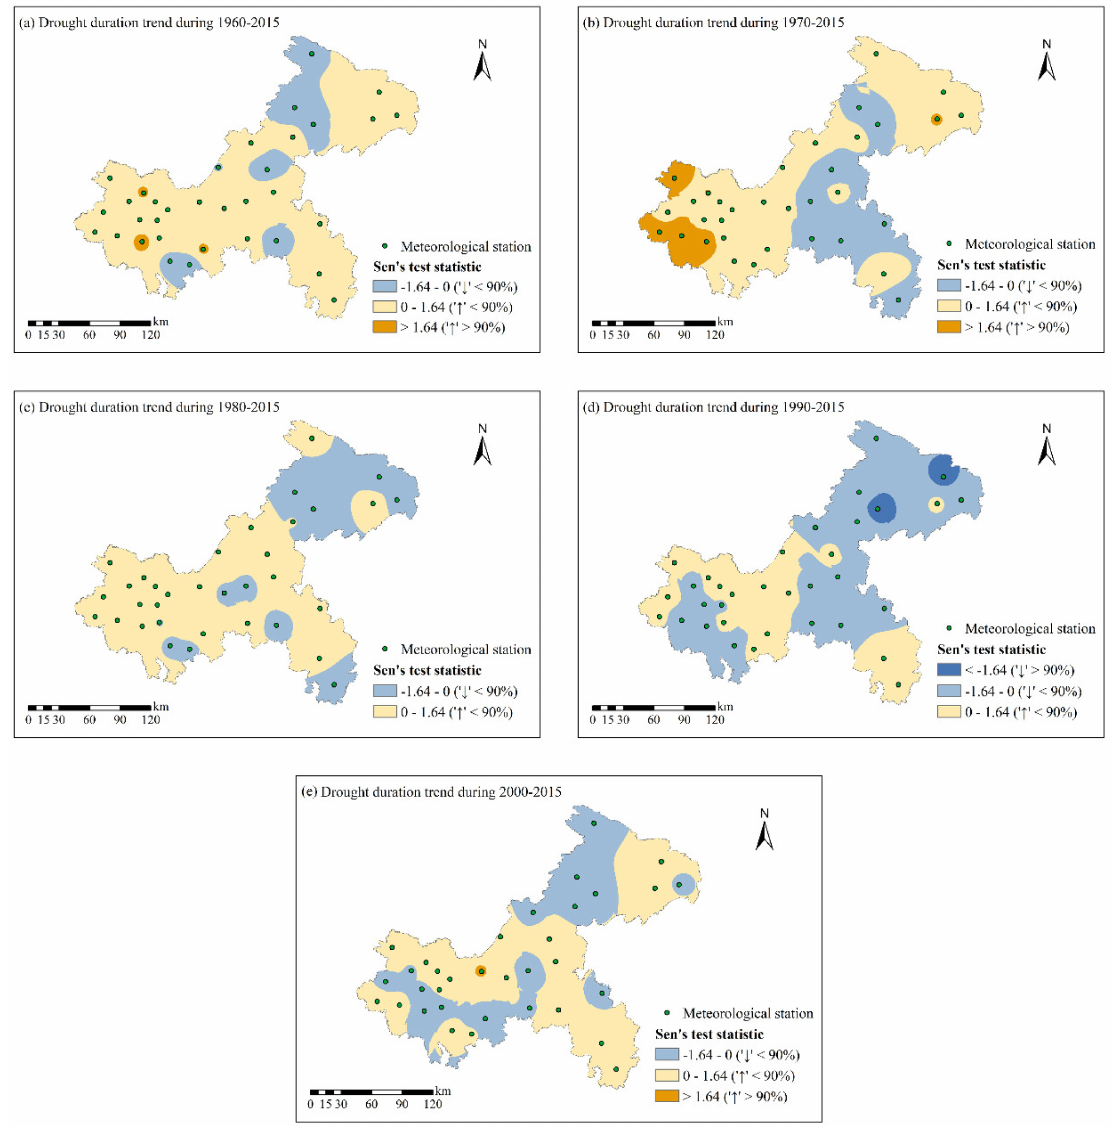
Figure 4. Spatial distribution of trend evolution of annual drought duration for ( a ) 1960–2015, ( b ) 1970–2015, ( c ) 1980–2015, ( d ) 1990–2015, and ( e ) 2000–2015 based on Sen’s trend